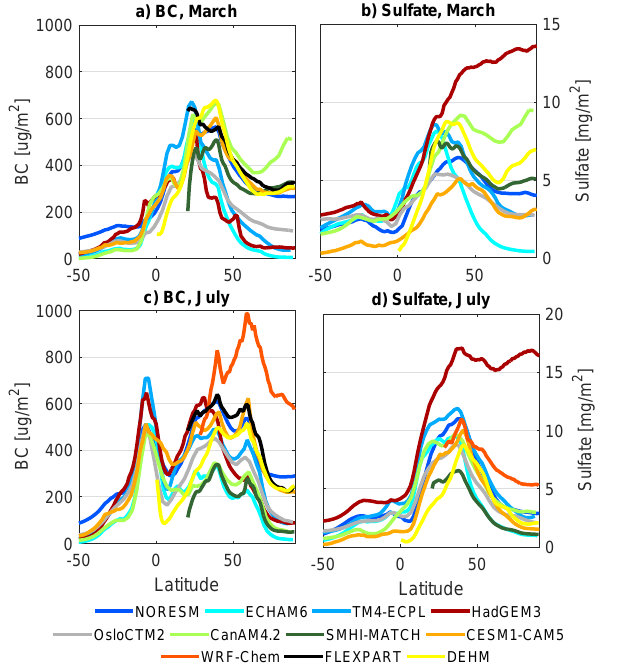
Figure 3. BC (a – b, e – f) and sulfate (c – d, g – h) mass mixing ratios for the year 2008 at the surface averaged over all longitudes as a function of latitude (for the range 50 ◦ S to 90 ◦ N) for March (a – d) and July (e – h) . The right panels show the same data as the left panels, but only for 70–90 ◦ N and with an adjusted ordinate scale.